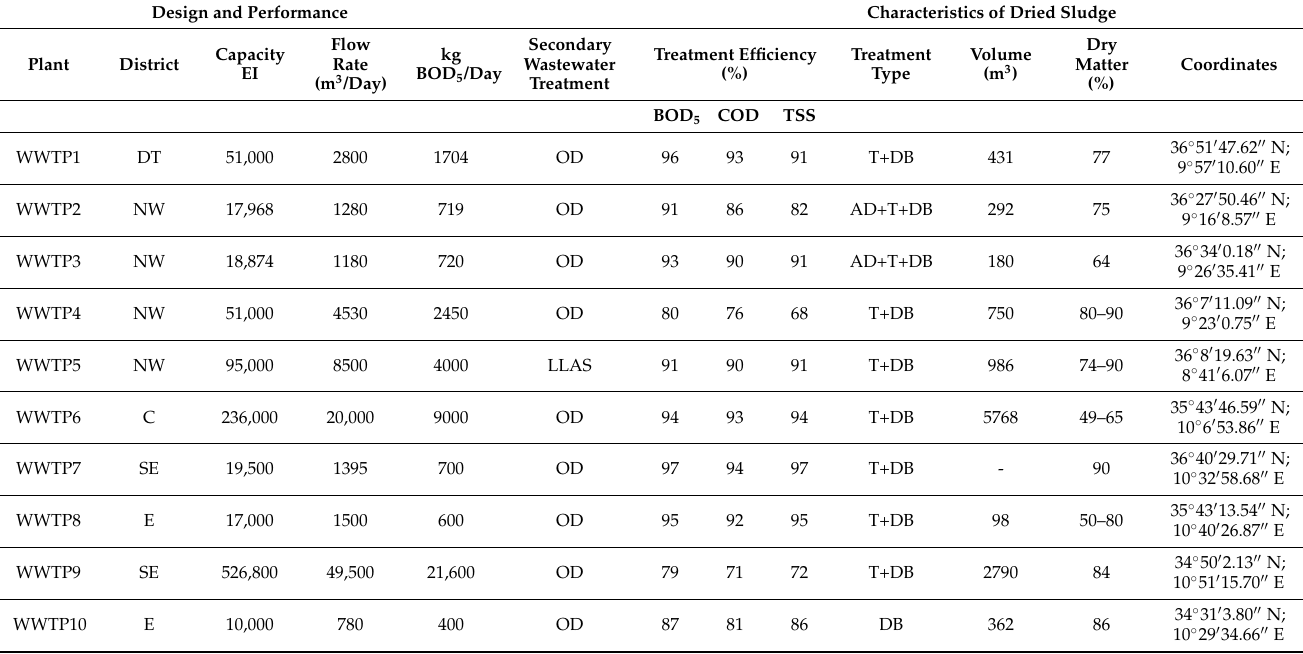
Table 2. Main characteristics of sewage sludge from WWTPs used in this study